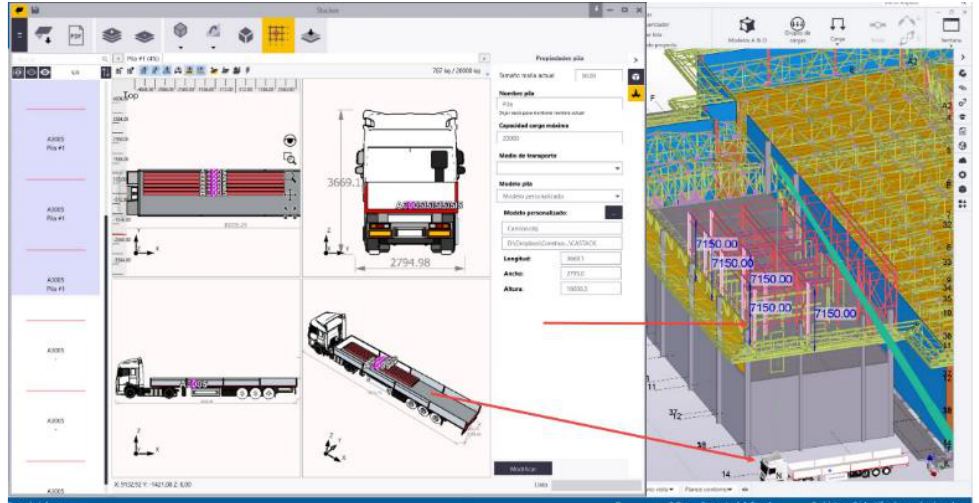
Figure 19. Steel BIM truck loading sample.